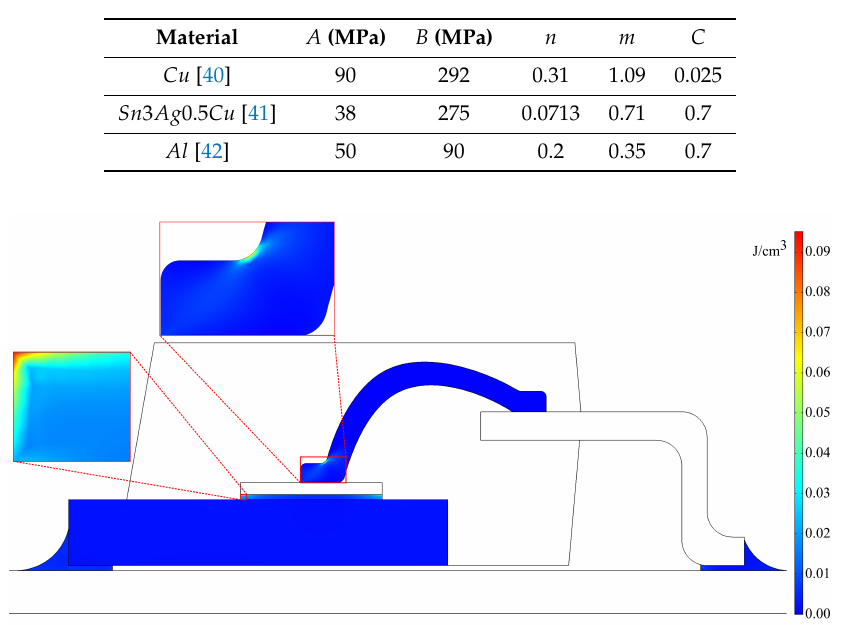
Table 5. Parameters used in the Johnson-Cook constitutive material model.